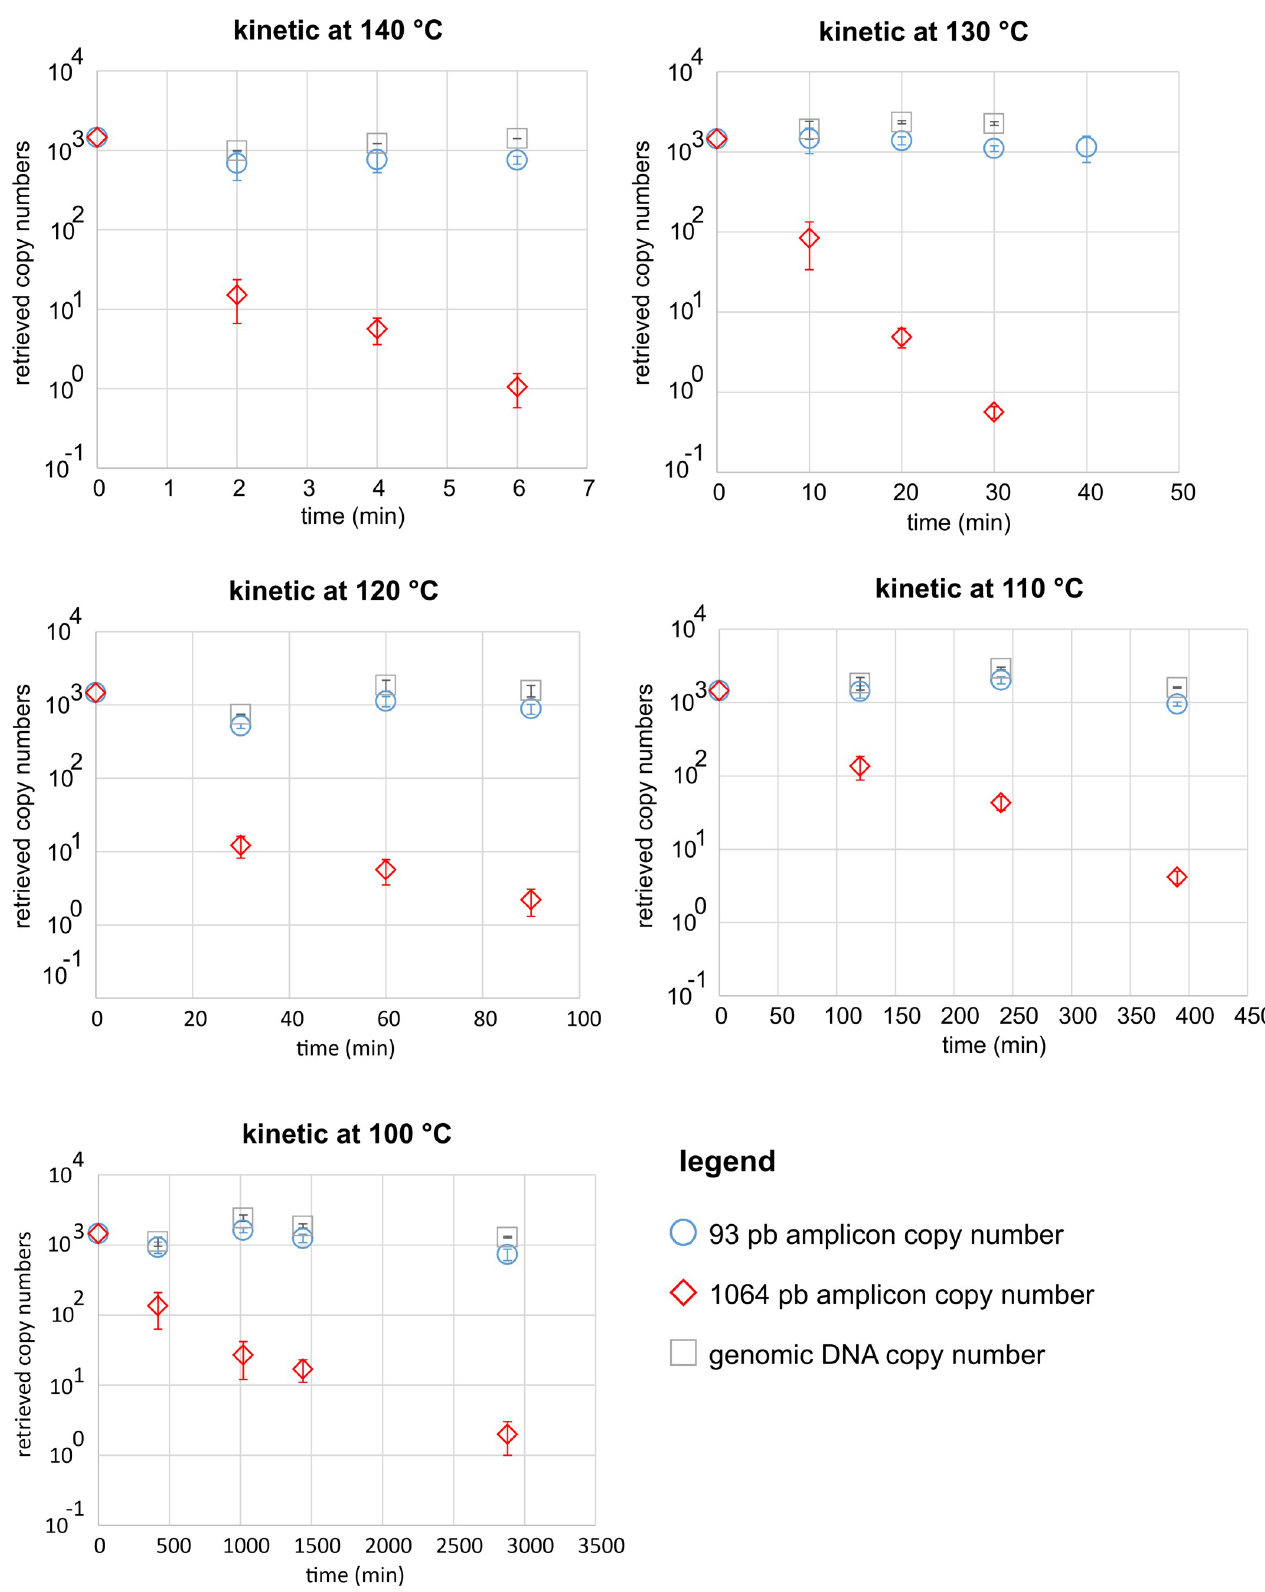
Fig 3. Amplifiable copy numbers of 1064 amplicon, 93 amplicon and genomic DNA. https://doi.org/10.1371/journal.pone.0259868.g003 PLOS ONE | https://doi.org/10.1371/journal.pone.0259868 November11,